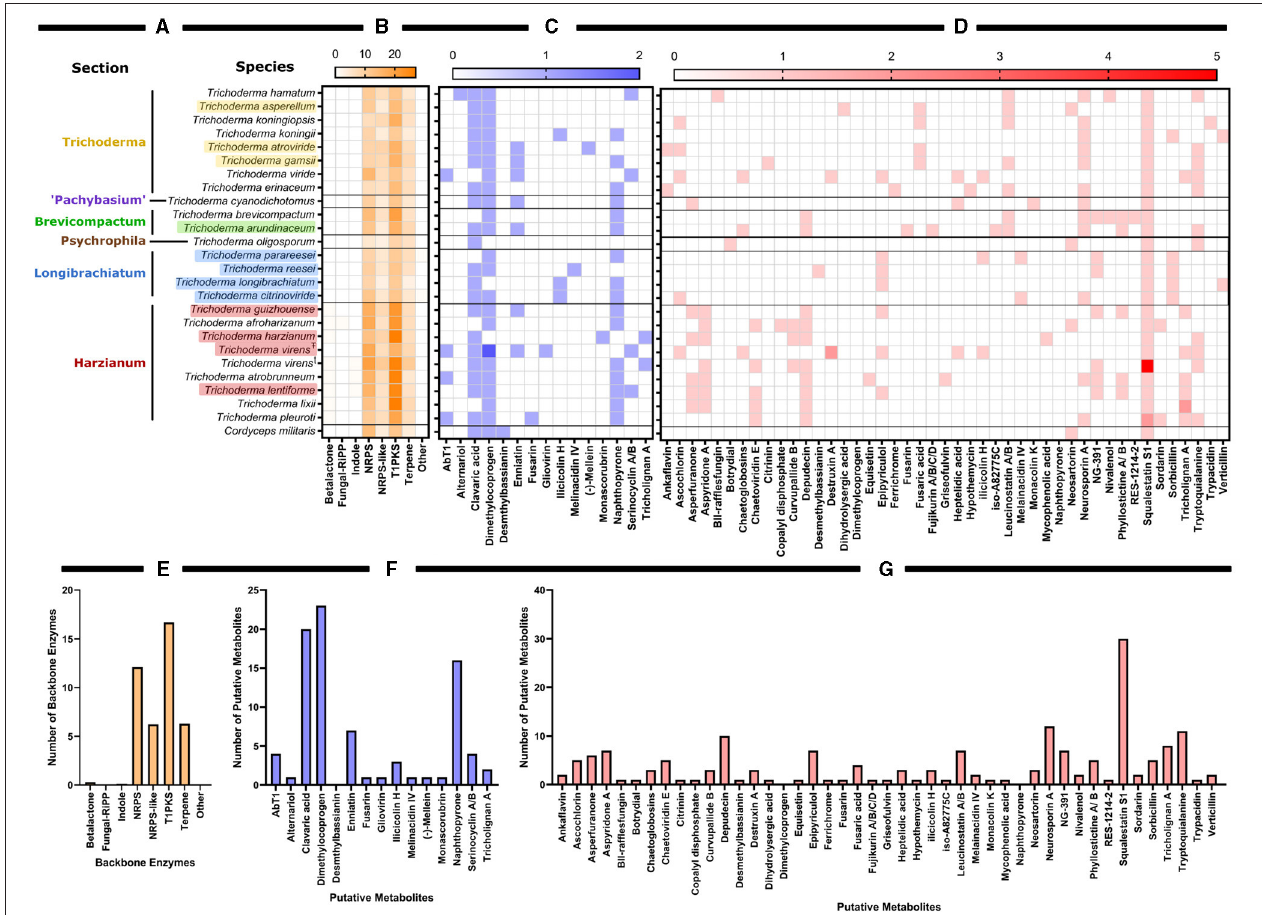
FIGURE 5 | Predictive backbone enzymes an putative metabolites identified by antiSMASH for the available whole genomes of Trichoderma species. (A) Nucleotide genomes of Trichoderma spp. organized by their sections as determined by protein-based genome alignment as shown in Figure 6 and corresponding published data from Druzhinina and Kubicek (2005), Zhu and Zhuang (2015), Li J. et al. (2018), and Cai and Druzhinina (2021). Colored species names correspond with Figure 6 . Black text species names correspond with the previous publications on Trichoderma taxonomy. Genomes are aligned with corresponding heat map showing (B) the number of backbone enzymes and (C) putative metabolites with a ≥ 75% or (D) < 75% sequence match with known metabolites. (E) The total number of backbone enzymes found in all species examined. (F) The total number of putative metabolites with a sequence match ≥ 75% with known metabolites found in all species examined. (G) The total number of putative metabolites with a sequence match < 75% with known metabolites found in all species examined. Strains of T. virens noted as (T) are strain Gv29-8 and as ( T) are strain IMV